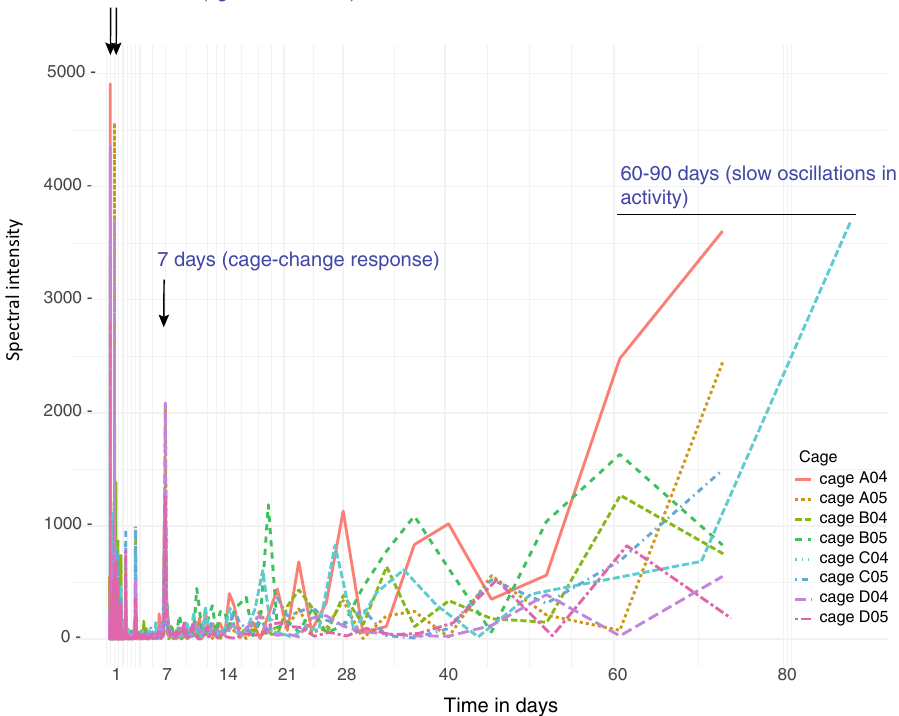
Figure 3. Superimposed spectrograms of activations clustering at different frequencies of eight cages (color coded; key is to the right in the spectrogram) with male mice in group 1 (see Methods). Note the precise timing across cages of the behaviors triggered by environmental stimuli, while the slow oscillations having a periodicity in the range of 60–90 days are not synchronized across cages . The slow peaks are generated by only